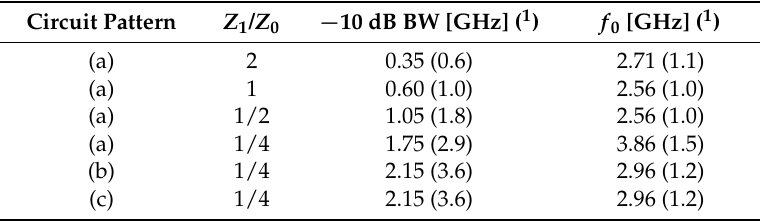
1 Indicate the magnification for Z